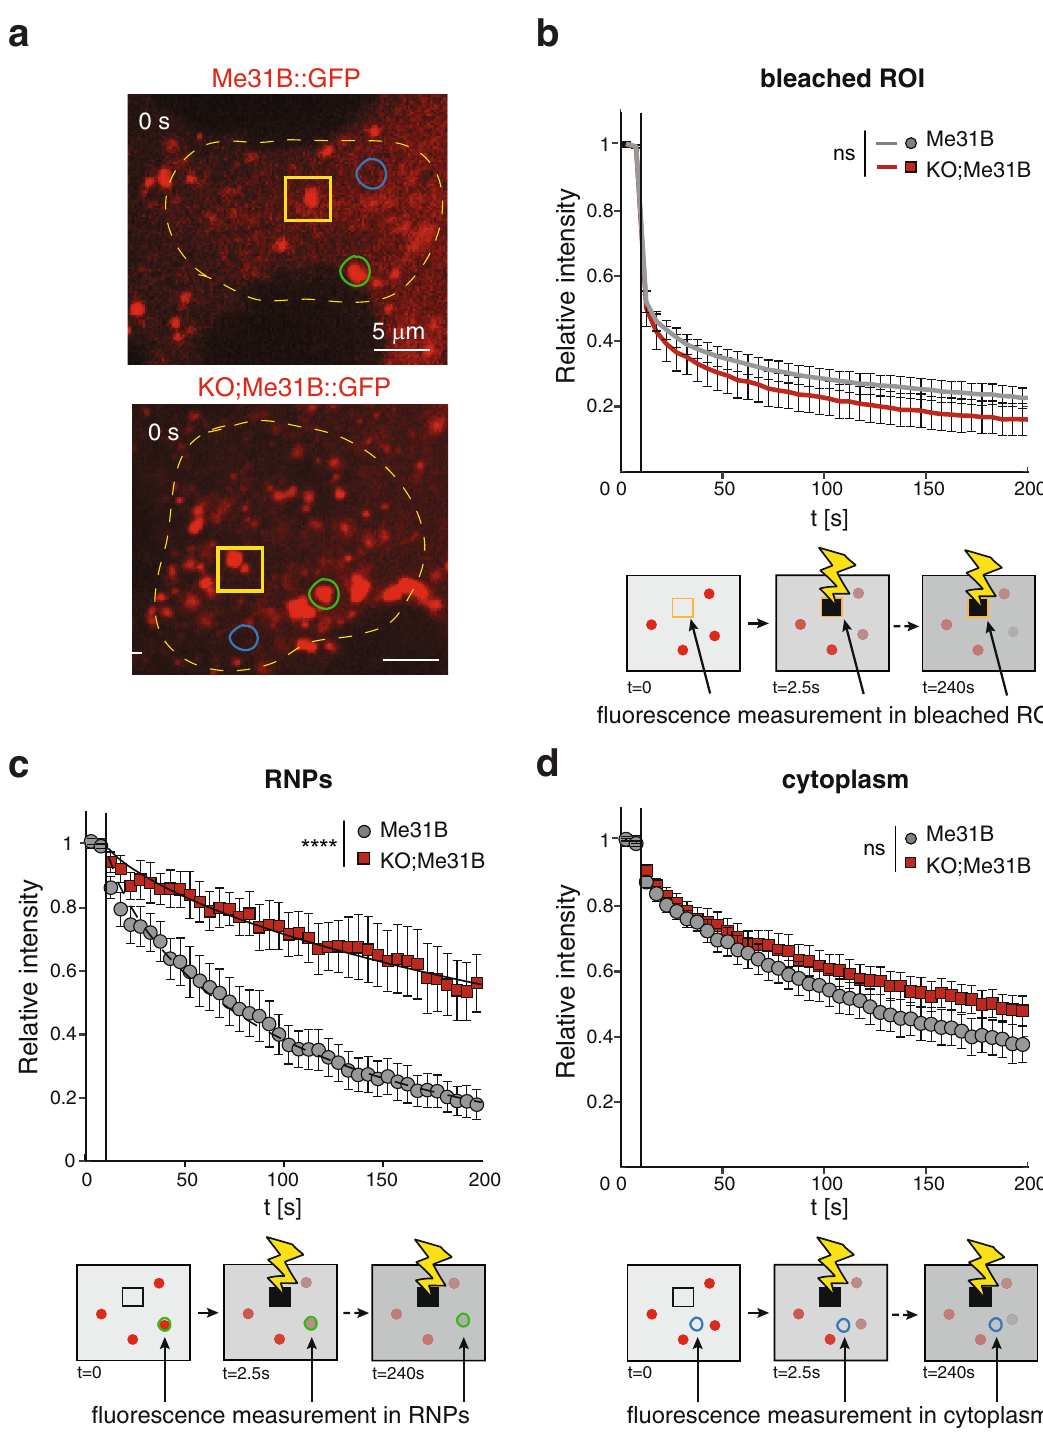
Fig. 6 Lack of Hecw alters the RNP biophysical proprieties. a FLIP analysis was performed by repeatedly bleaching a randomly selected ROI (indicated by a yellow square) and by monitoring and quantifying the fl uorescence level as a function of time in the same region, in single RNPs outside the bleached area (green circle), and in neighbouring portions of the cytoplasm (blue circle). One representative image for each genotype is shown. In ( b ), ( c ) and ( d ), the relative intensity of Me31B::GFP fl uorescence in the three regions: bleached area, RNPs and cytoplasm, respectively, is plotted as a function of time for both control and Hecw KO . Data are reported as mean ± SD. **** P < 0.0001 by two-tailed Mann – Whitney test ( n = 18 samples/genotype). Both in the bleached area and in the cytoplasm, the loss curves show no statistically signi fi cant difference ( P = 0.07 by t -student) between control and Hecw KO , whereas a highly signi fi cant difference is observed for